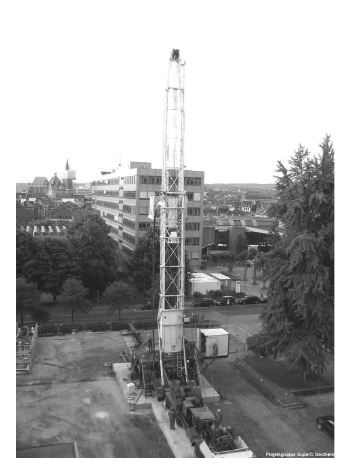
Figure 1: Mobile drill rig in the center of the city Aachen.